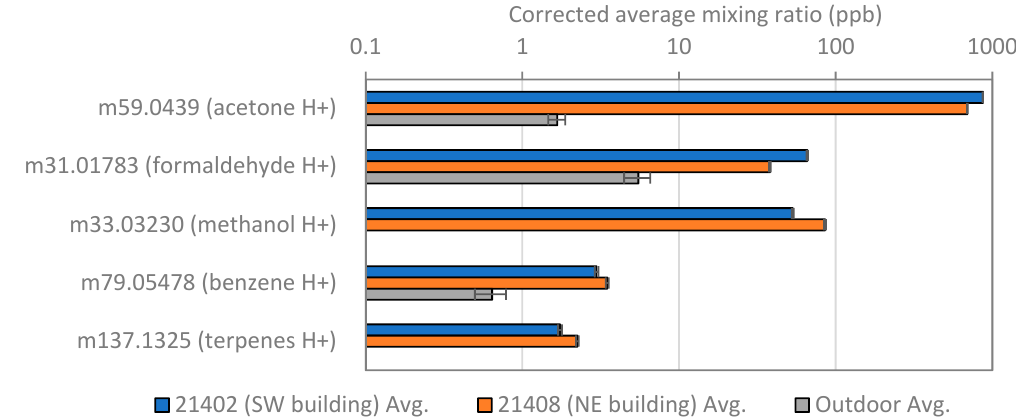
Figure 5. VOC results for five compounds from PTR-TOF-MS analysis of week 3 HeDS canisters from southwest and northeast indoor monitoring kit locations and from the outdoor evacuated canister location on the roof.